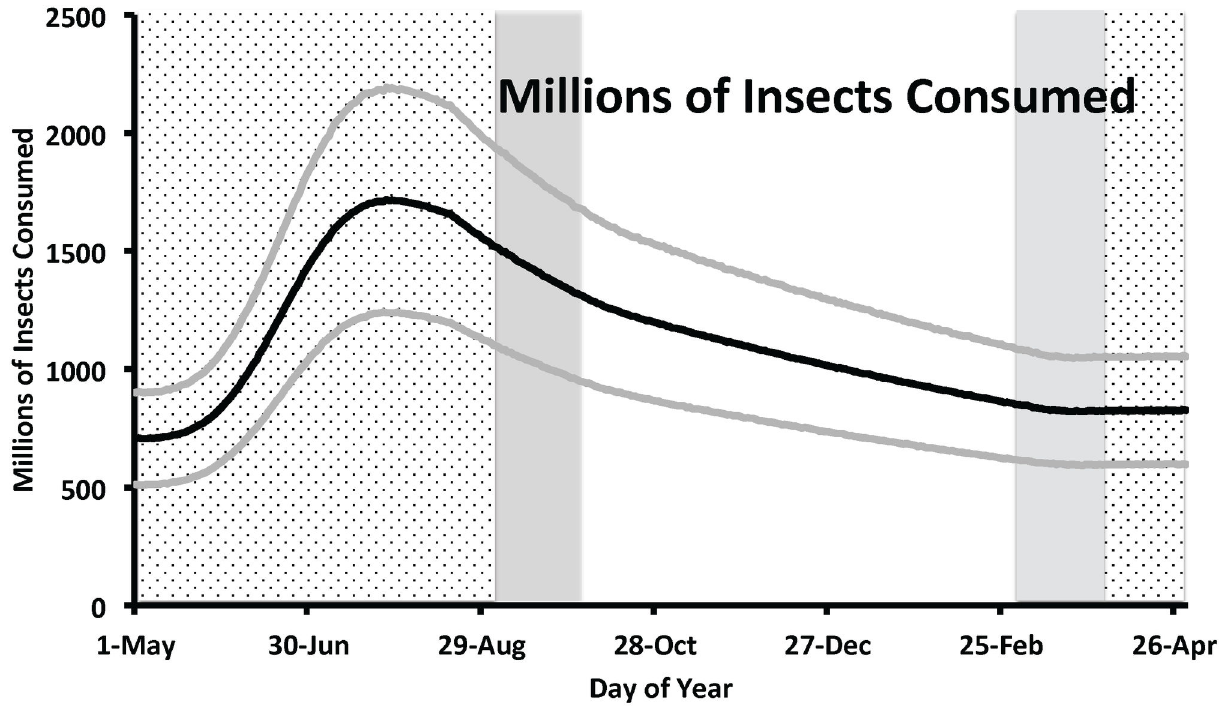
Figure 3. Estimated mean number (black line) ± standard deviation (gray lines) of insects consumed by Purple Martins based on 10,000 replications of an energetics simulation model. Background shading indicates phase of the annual cycle as breeding season (stippling), migration (gray), and winter (no shading).